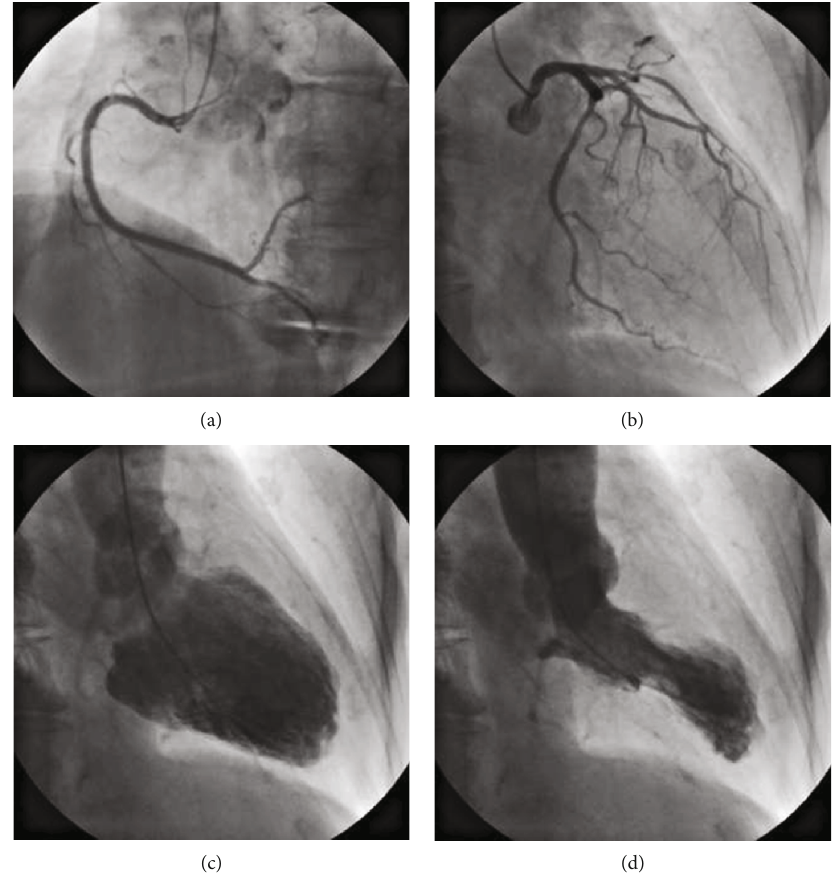
Figure 2: On hospital day 8, a coronary angiogram shows no stenosis: (a) right coronary artery; (b) left coronary artery. Left ventricular angiography shows hypokinesis from the midventricle to the apex and hyperkinesis in the basal segments: (c) end-diastole; (d)